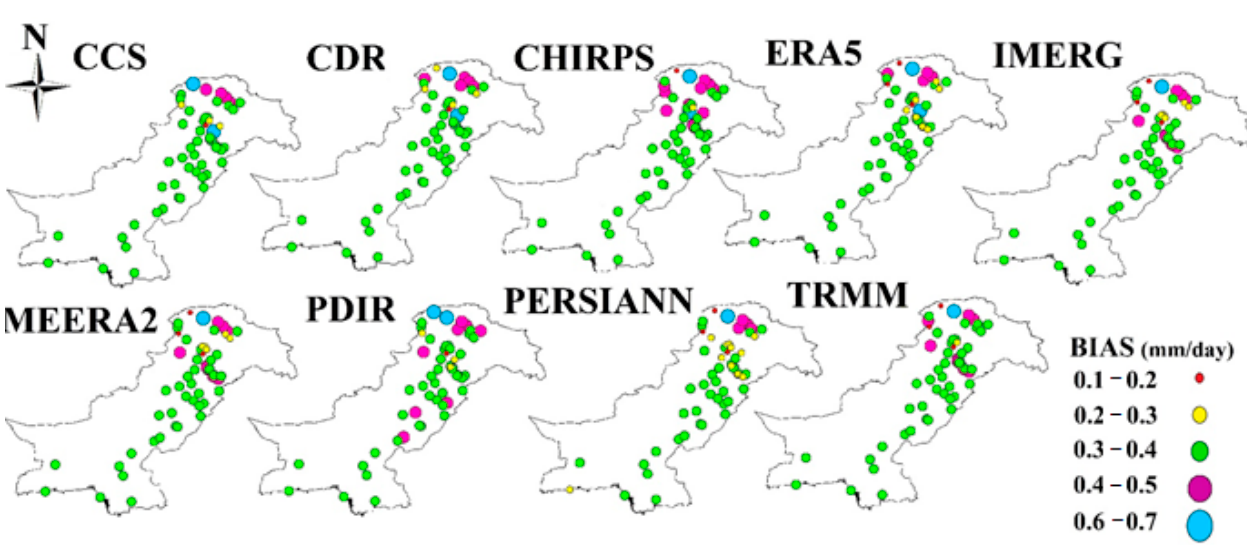
Figure 12. Spatial distribution of CC values estimated for nine precipitation products.